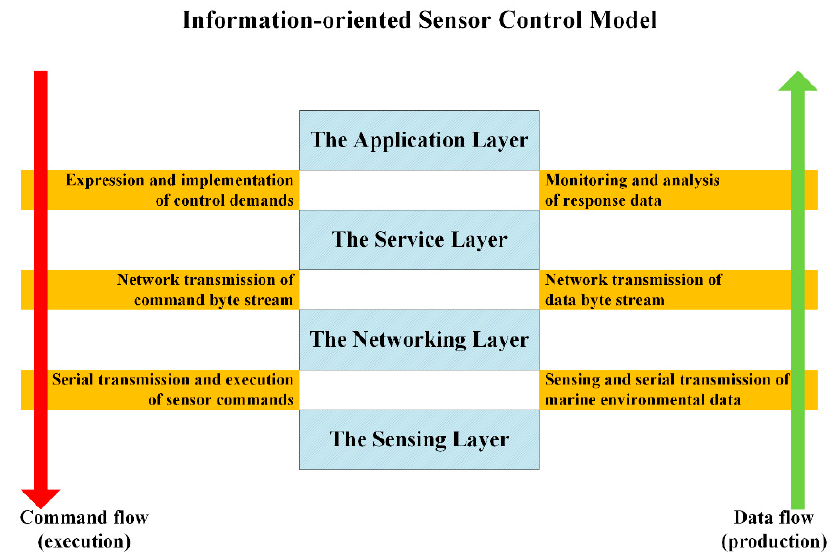
Figure 2. Information-oriented Sensor Control Model.